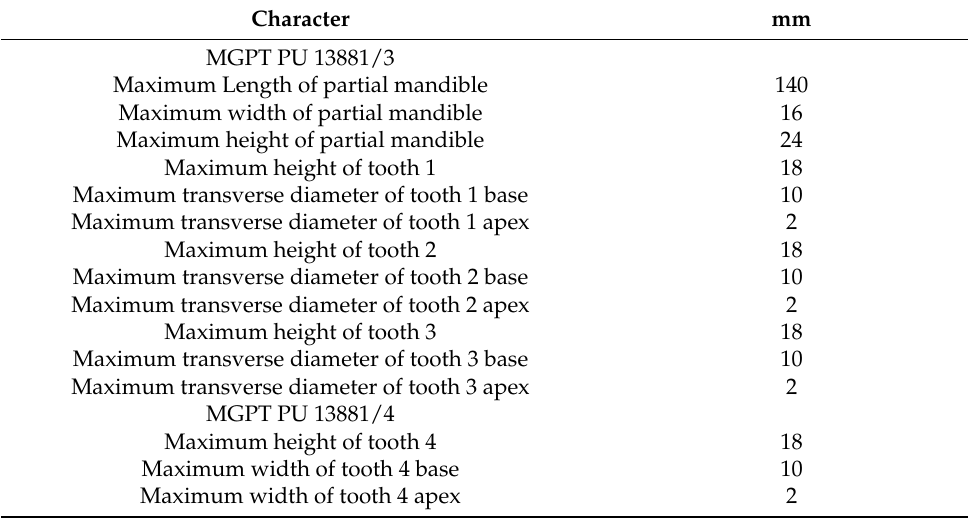
Table 3. Measurements of MGPT PU 13881/3-4 in